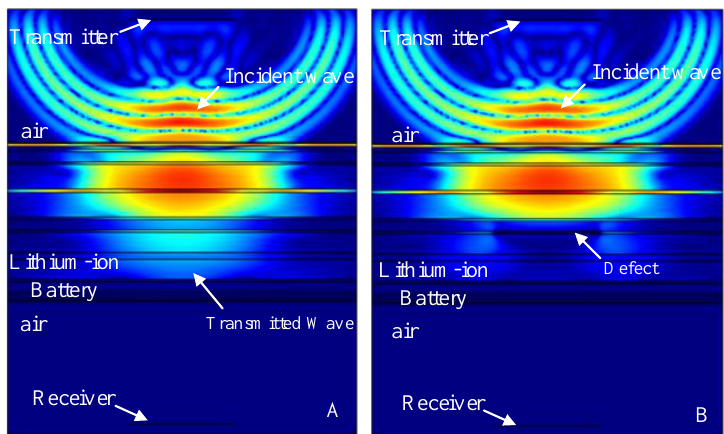
Figure 15. Finite element simulation of time snapshots of the propagation of the ultrasonic wave in the lithium- ion battery (12.186 μs). ( A ) The simulation result without a defect; ( B ) the simulation result with a stomata defect in the fourth electrolyte layer.